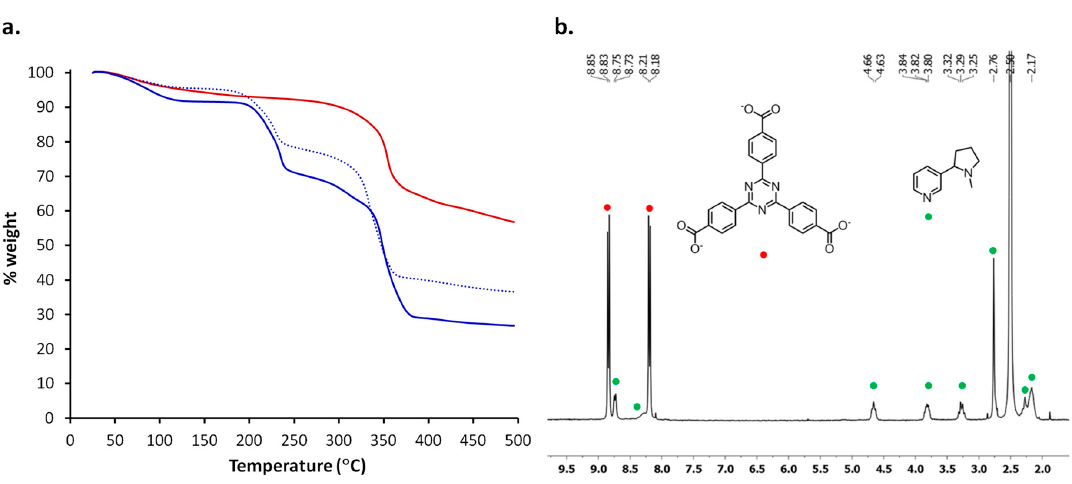
Figure 7. ( a ) TGA traces of PCN-6 ′ after activation (red), PCN-6 ′ @nicotine (blue) and PCN-6 ′ @nicotine after six months (dotted blue); ( b ) 1 H NMR spectrum of PCN-6 ′ @nicotine recorded after dissolution of the crystal in a TFA-d/DMSO-d 6 mixture. The signals of the ligand TATB are indicated with red bullets, while the signals belonging to nicotine are indicated with green bullets.